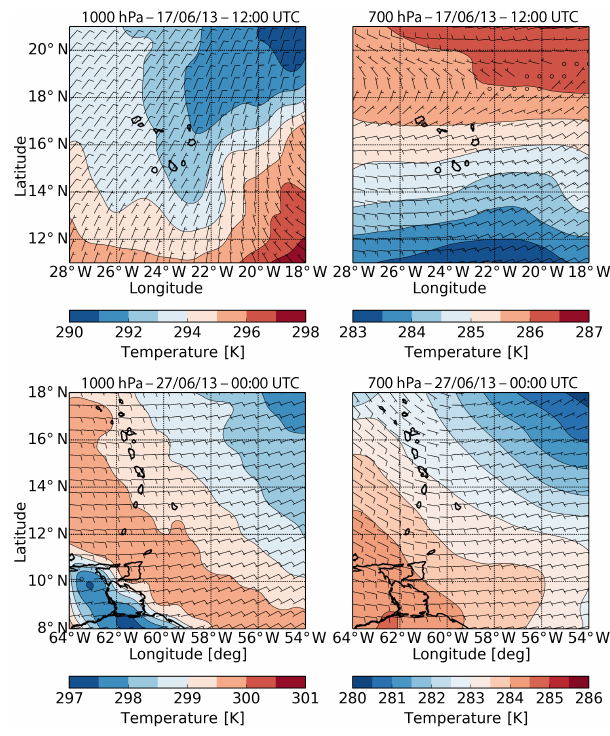
Figure 5. Synoptic conditions derived from the ECMWF ERA- Interim reanalysis over the Cabo Verde islands (upper panels) and Barbados (lower panels) for the 17 and 27 June 2013 respectively. Wind vectors (barbs, in ms − 1 ) and temperature (in ◦ K) are shown.